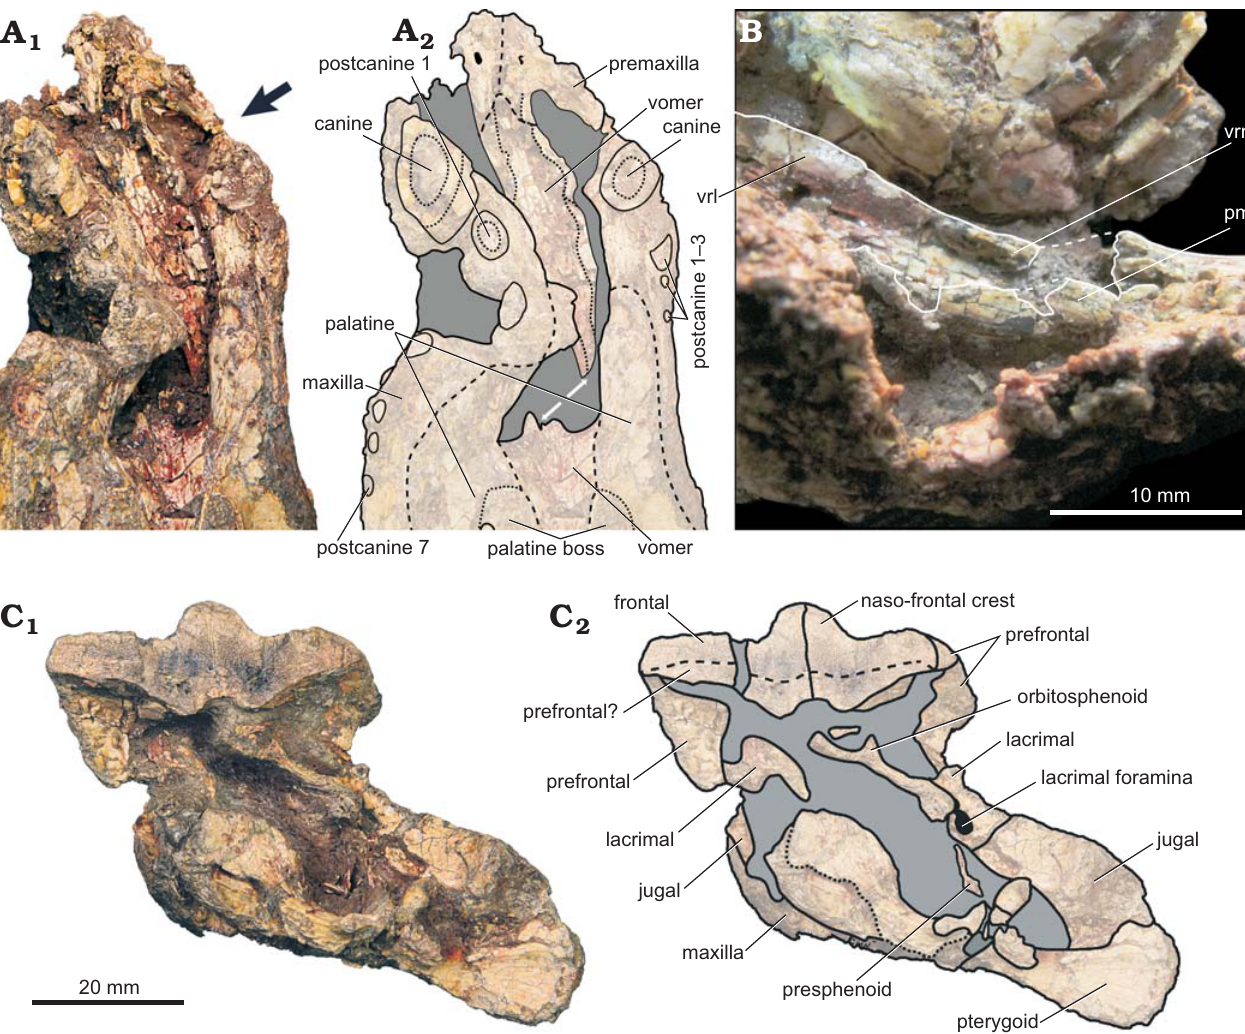
Fig. 5. Burnetiamorpha gen. et sp. indet. (BP/1/7098) from Springfontein, Beaufort West district, South Africa; upper Poortjie Member, Pristerognathus AZ, latest Capitanian. A . Anterior palate in ventral view, black arrow shows direction of view in B; white arrows show lateral displacement of intercho- anal portion of the vomers. B . Interchoanal portion of vomers in right ventral view ( B ), showing the continuation of the downturned edges of the vomer extending anteriorly onto the premaxilla; pmr, ventral ridge of premaxilla at anterior margin of choana; vrl, ventral ridge of vomer laterally flared; vrm, ventral ridge of vomer medially folded. C . Specimen in posterior view. Photographs (A 1 , C 1 ) and explanatory drawings (A 2 , C 2